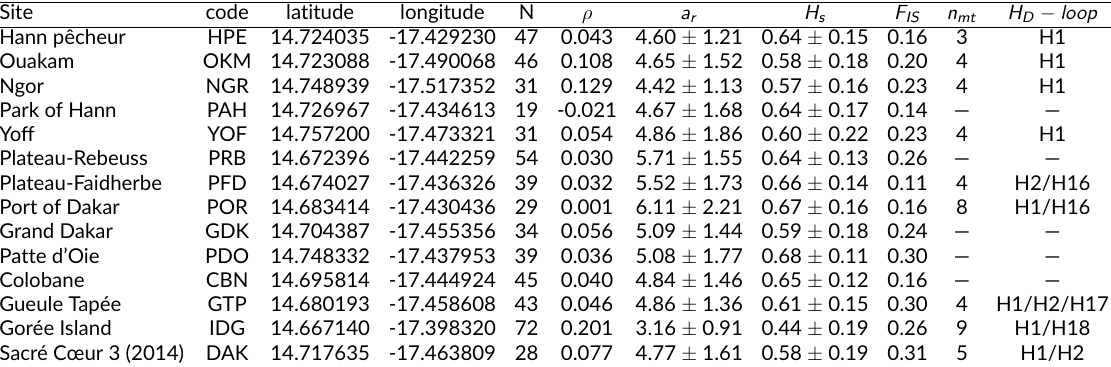
Table 2 – Characteristics of the sampling sites of Mus musculus domesticus in Dakar,